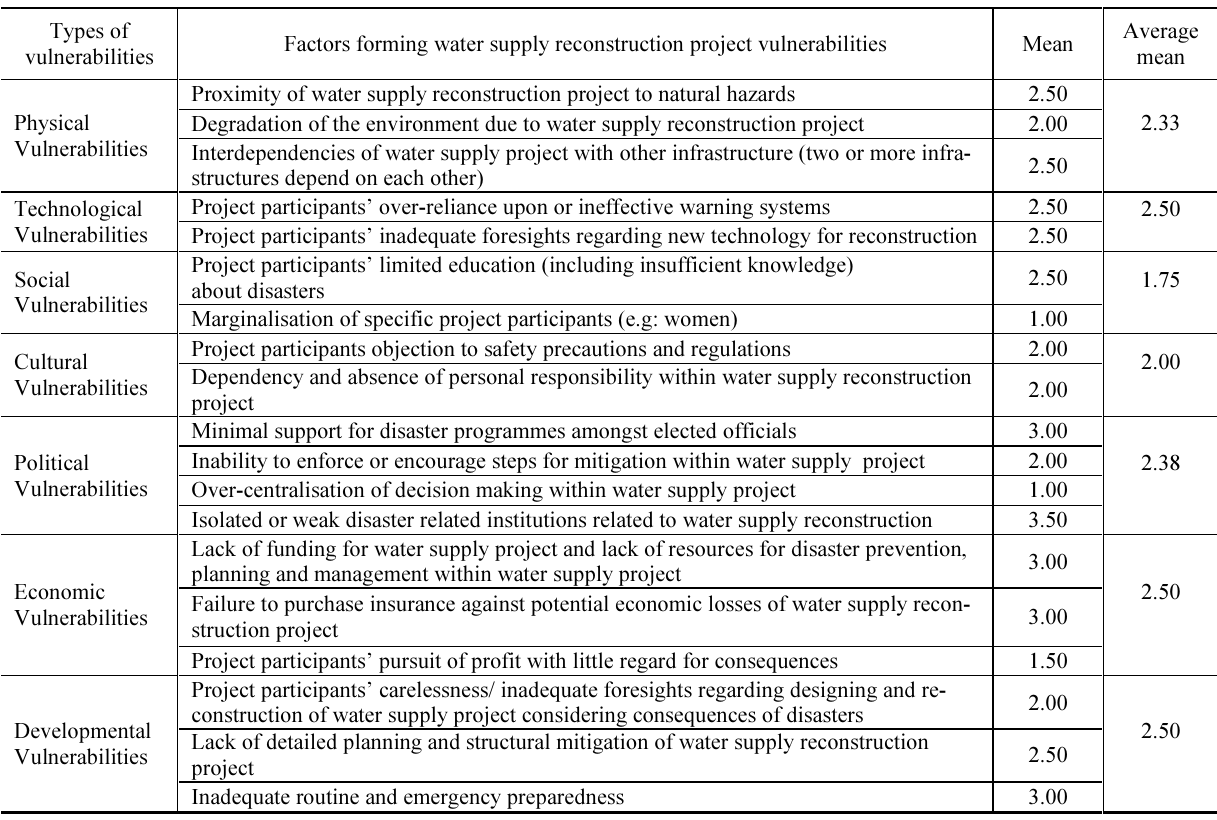
Table 1. Vulnerabilities of the water supply reconstruction project Types